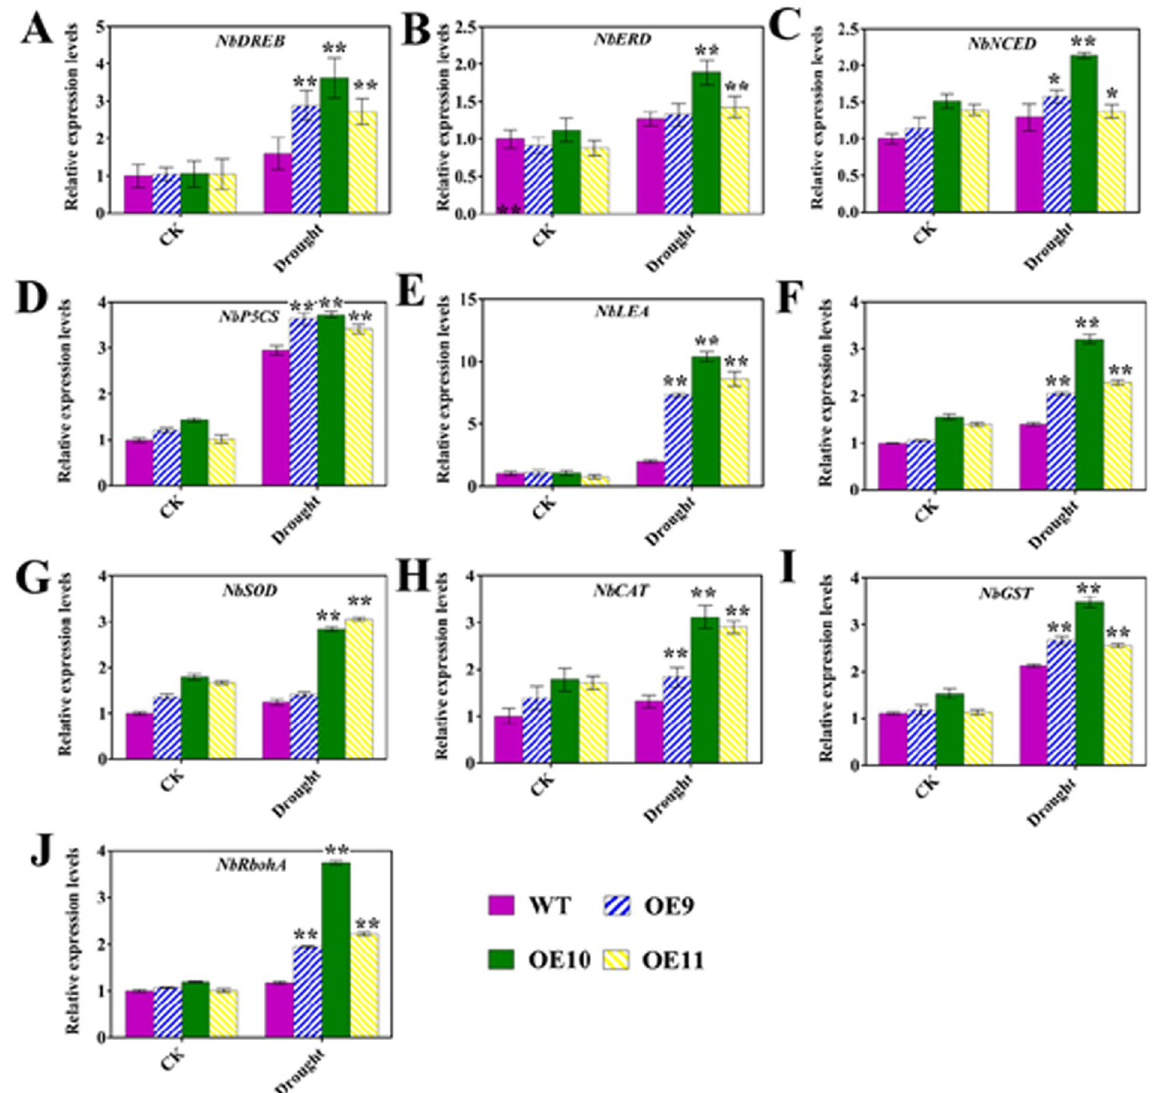
Figure 7. Expression of some antioxidant-and drought-related genes in OE and WT plants under drought stress. The histograms indicate the expression levels of the mentioned genes (A – J) in the transgenic and WT plants relative to their levels in the WT plants, which were considered as 1. Expression was normalized to the level of expression of actin in each sample was taken as the control. The experiments were repeated three times and the bars indicate SEs. * and ** indicate significant differences at P < 0.05 and P < 0.01 in the values among the three overexpression lines and the WT